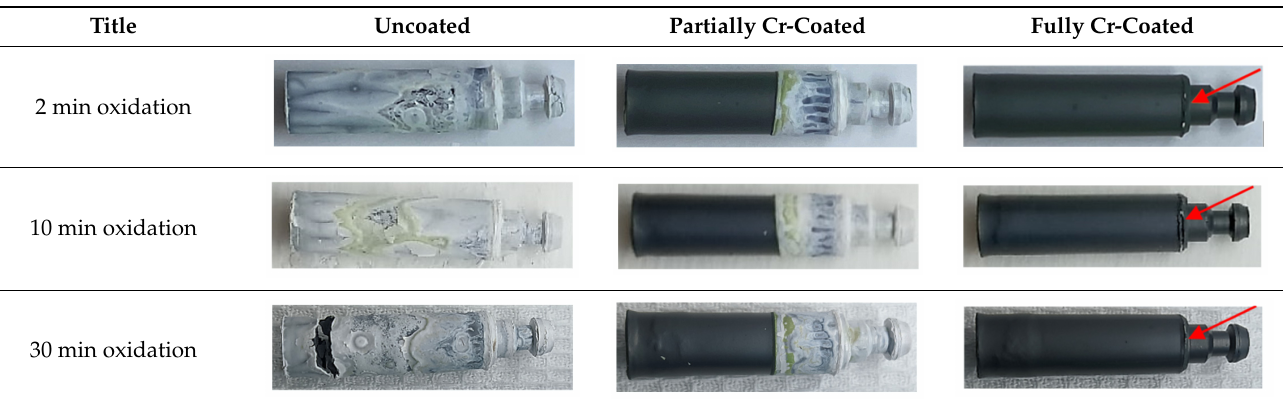
Table 2. The outer view of the samples after